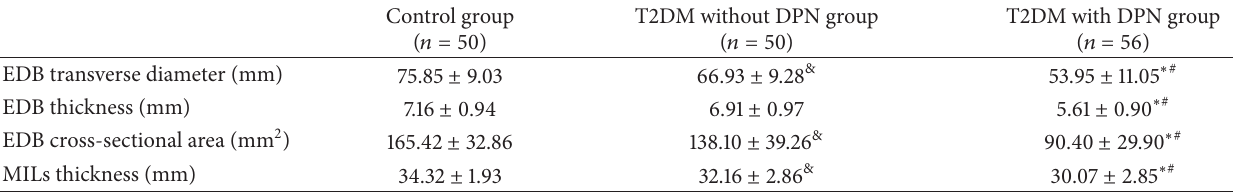
Table 2: Measured foot muscle atrophy in Chinese diabetic patients and the matched control subjects.